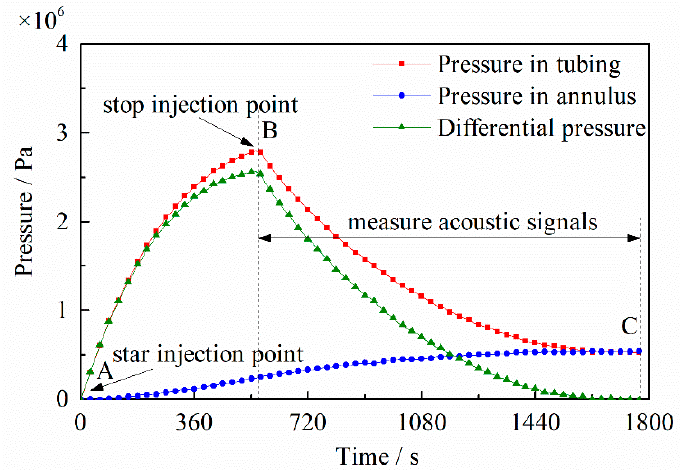
Figure 9. Pressure curve in experiment.